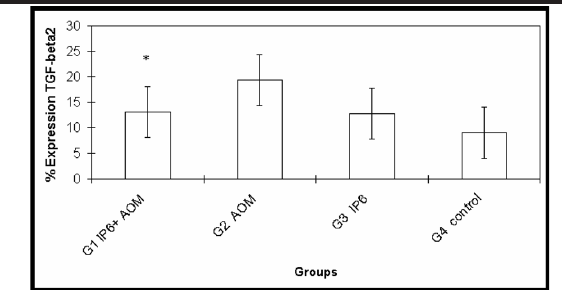
FIGURE 4 - Schematical representation of significant influence of inositol hexaphosphate on TGF beta 2 expression in aberrant crypt foci in colon (Group 1) at the end of the sixth- week experiment, as compared with group 2, in azoxymethaneinduced colon carcinogenesis model in rats. * p